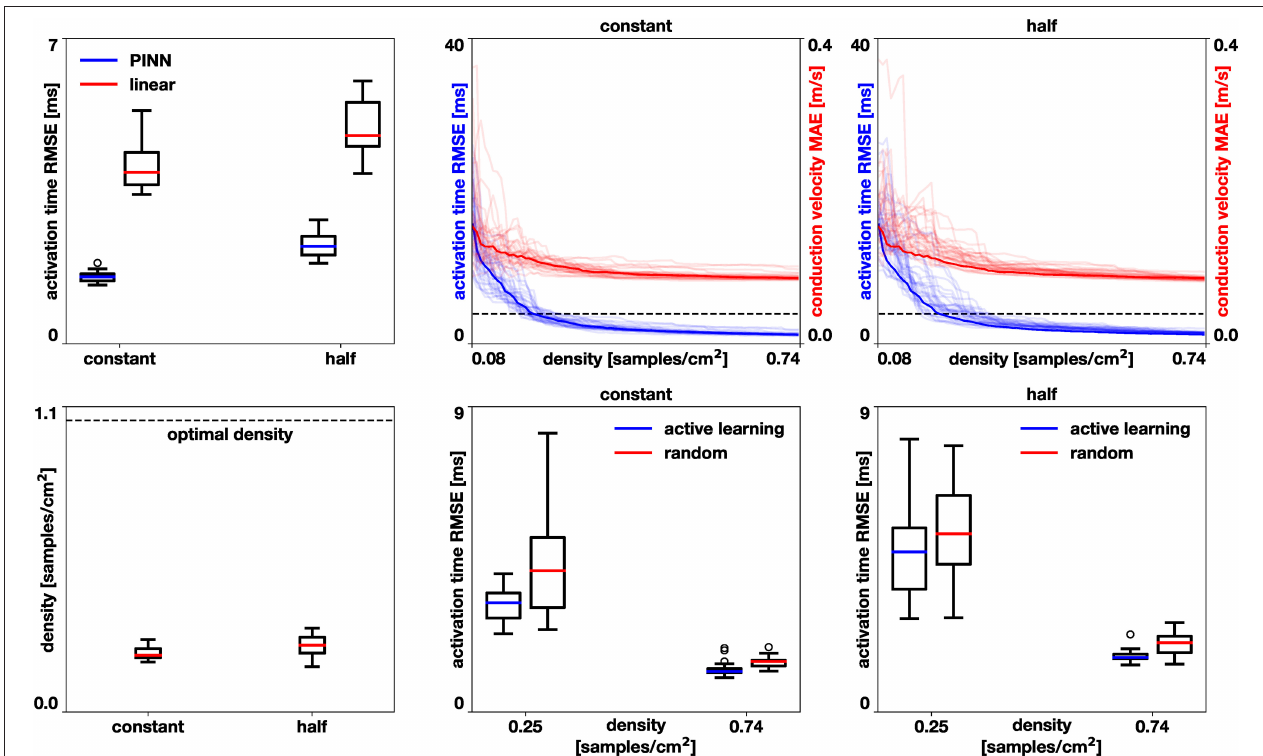
FIGURE 7 | Left atrium accuracy in activation times and conduction velocities. Performance of the physics-neural network (PINN) vs. linear interpolation, top left. The physics-neural network significantly reduces the root mean squared error (RMSE) in the homogeneous case with constant conductivity and in the heterogeneous case where the conductivity was reduced in half of the domain ( p < 10 − 5 ). Performance of the active learning algorithm for these two cases, top center and top right. Active learning decreases the root mean squared error of the activation times and the mean absolute error of the conduction velocity. The dashed line represents the median error achieved by linear interpolation at optimal sample density. Sample density required by the active learning approach to achieve the median error of the linear interpolation method at optimal sample density, bottom left. Comparison of active learning against random selection in the case of constant conductivity (bottom center) and reduced conductivity (bottom right). The active learning algorithm significantly reduces the error in all cases ( p <